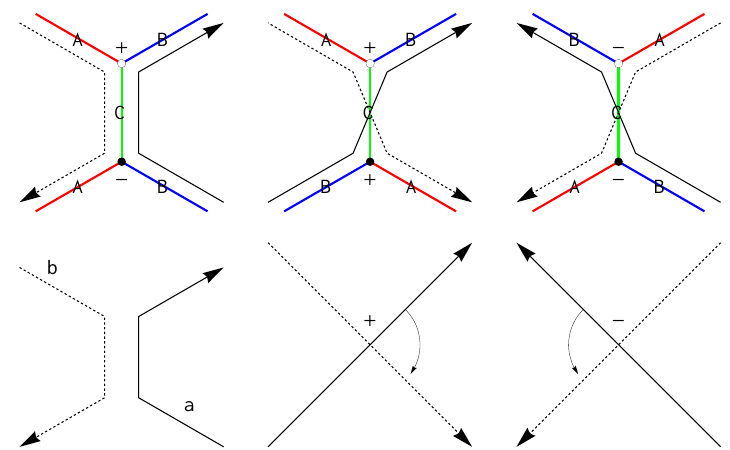
Figure 8: Correspondence between chirality and signed crossing of loops: a (black) and b (dashed) type loops cross at a C site. Left: They anti-cross when the chirality of the black and white vertex sums to zero. Middle and right: They cross with a ± sign when the chirality is ±